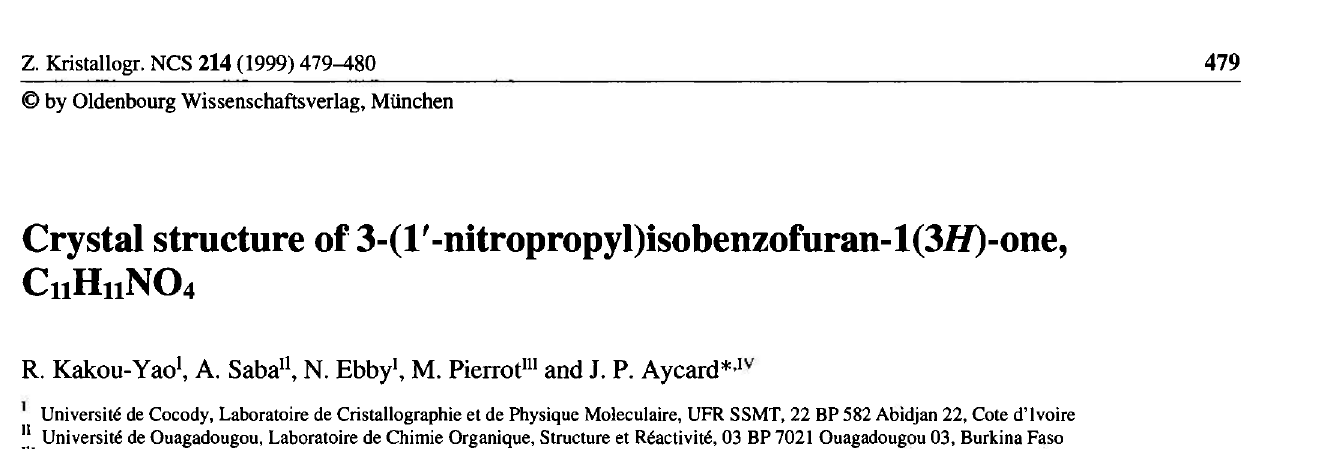
Table 1. Data collection and handling.